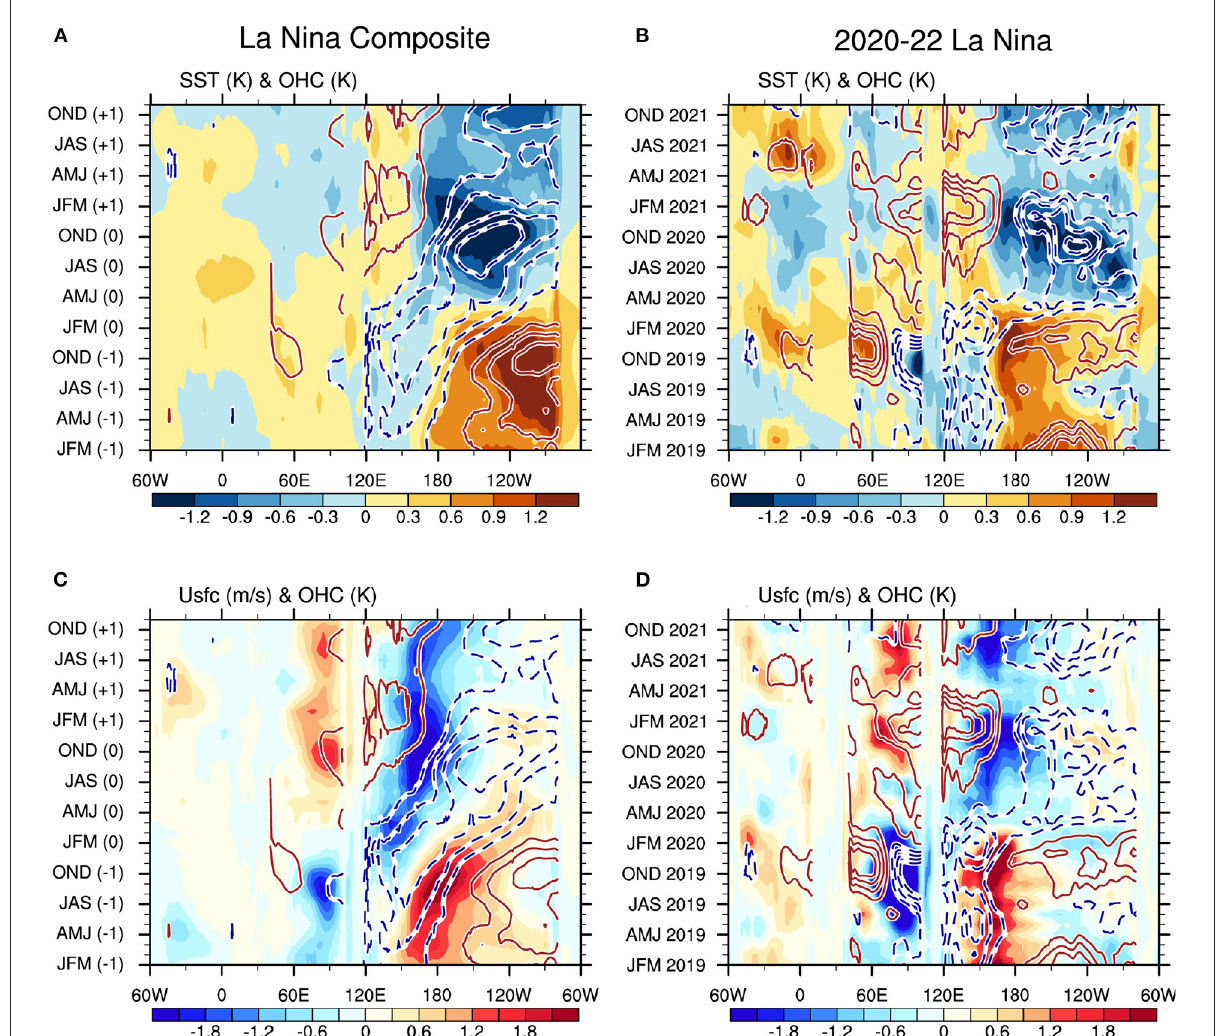
FIGURE4 Hovmöller diagrams of (A,B) SST (colors) and (C,D) surface zonal wind anomalies (colors) overlaying with OHC (contours) averaged over the 2.5 ◦ N–2.5 ◦ S latitude band in the typical La Niña composite (left) and the 2020–2022 case (right panels). The contour interval is 0.3. Positive and negative counters are red and blue lines, respectively. Anomalies are defined as deviations from climatological means, and linear trends are removed in each grid. As noted in parentheses after the season abbreviation, 0 indicates the first La Niña year, + 1 indicates the second La Niña year whereas − 1 indicates the preceding year of the first La